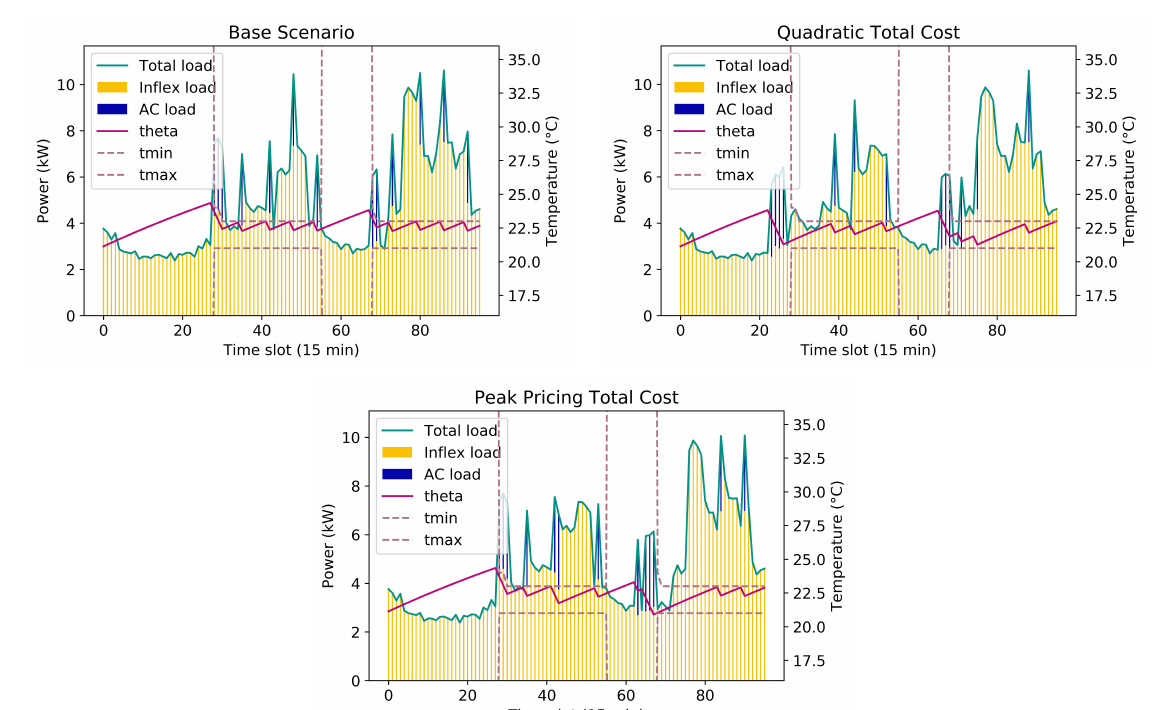
Figure 8. Final load curve with the dispatch of one consumer’s AC. Theta, tmin, and tmax are the temperature inside the room, the minimum, and the maximum comfort constraints,